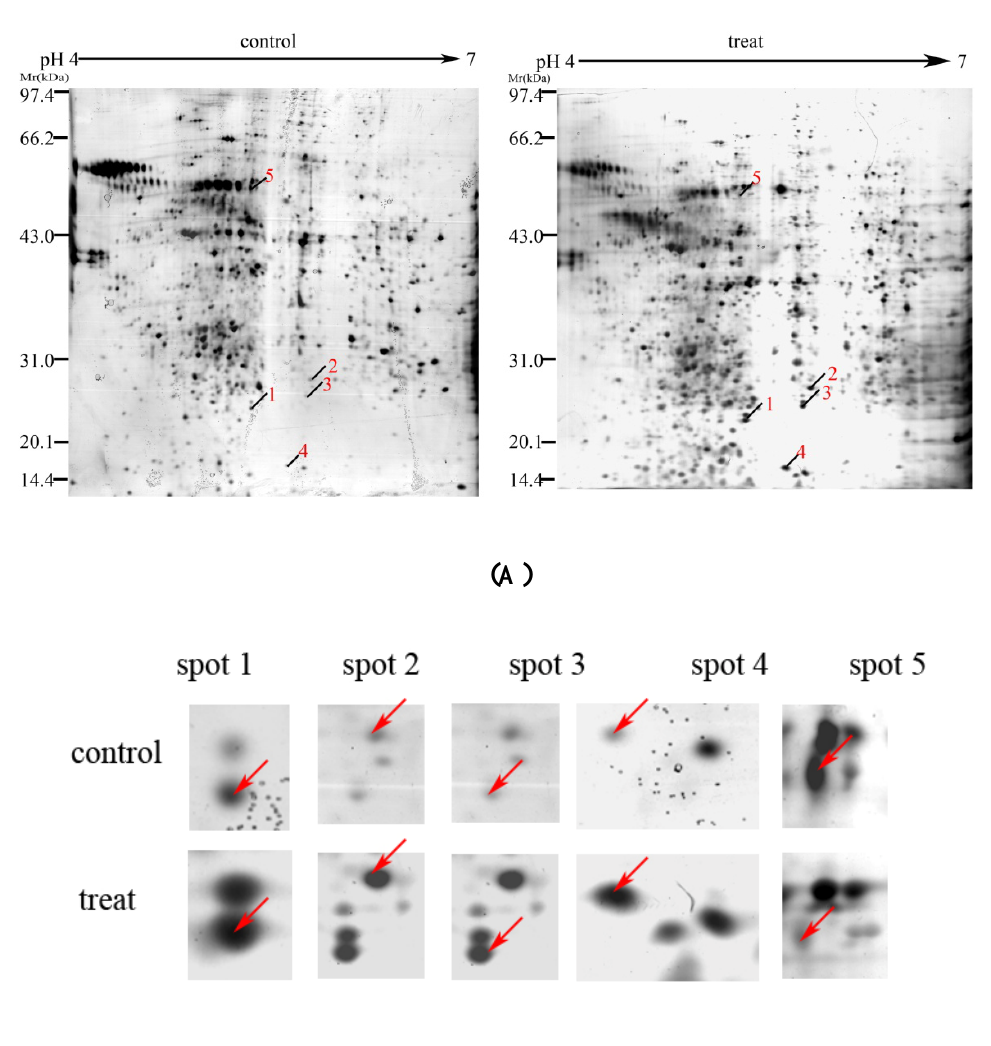
Figure 4. The proteome maps (2-DE images) of osteoclast induced from RAW 264.7 cells. Molecular weight (MW, kDa) and isoelectric point ( pI ) are indicated along the y- and x-axis, respectively (A). Selected regions show significant differences in protein expression profile of osteoclasts (B) between untreated and treated with 100 µg/mL of EXD for 48 h. Arrows indicate proteins that are differentially expressed absolutely. The gel images are the representative gel among nine replicate gels collected from three independent experiments. Differentially expressed protein spots indicated by lines and numbers were chosen for MALDI-TOF MS/MS analysis, outlined in Table